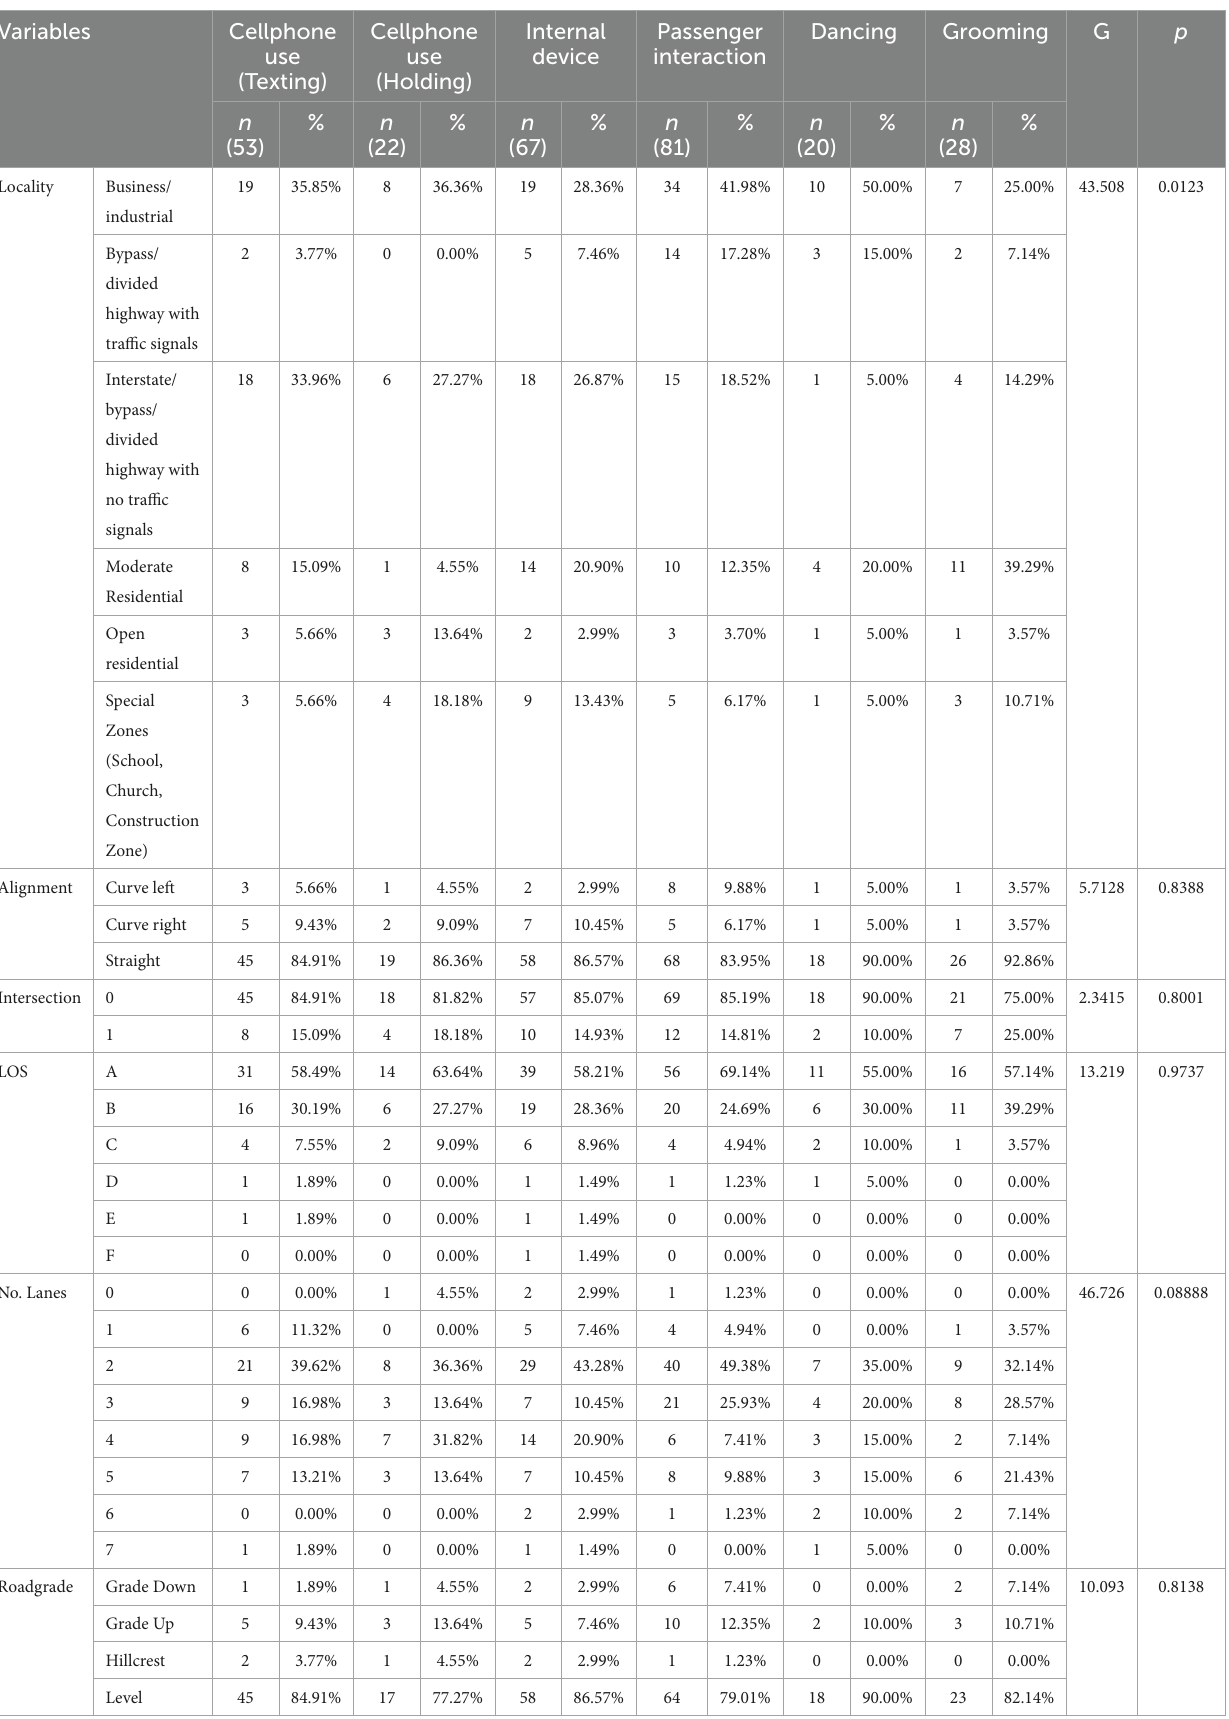
TABLE 3 Frequency of engagement in secondary tasks.